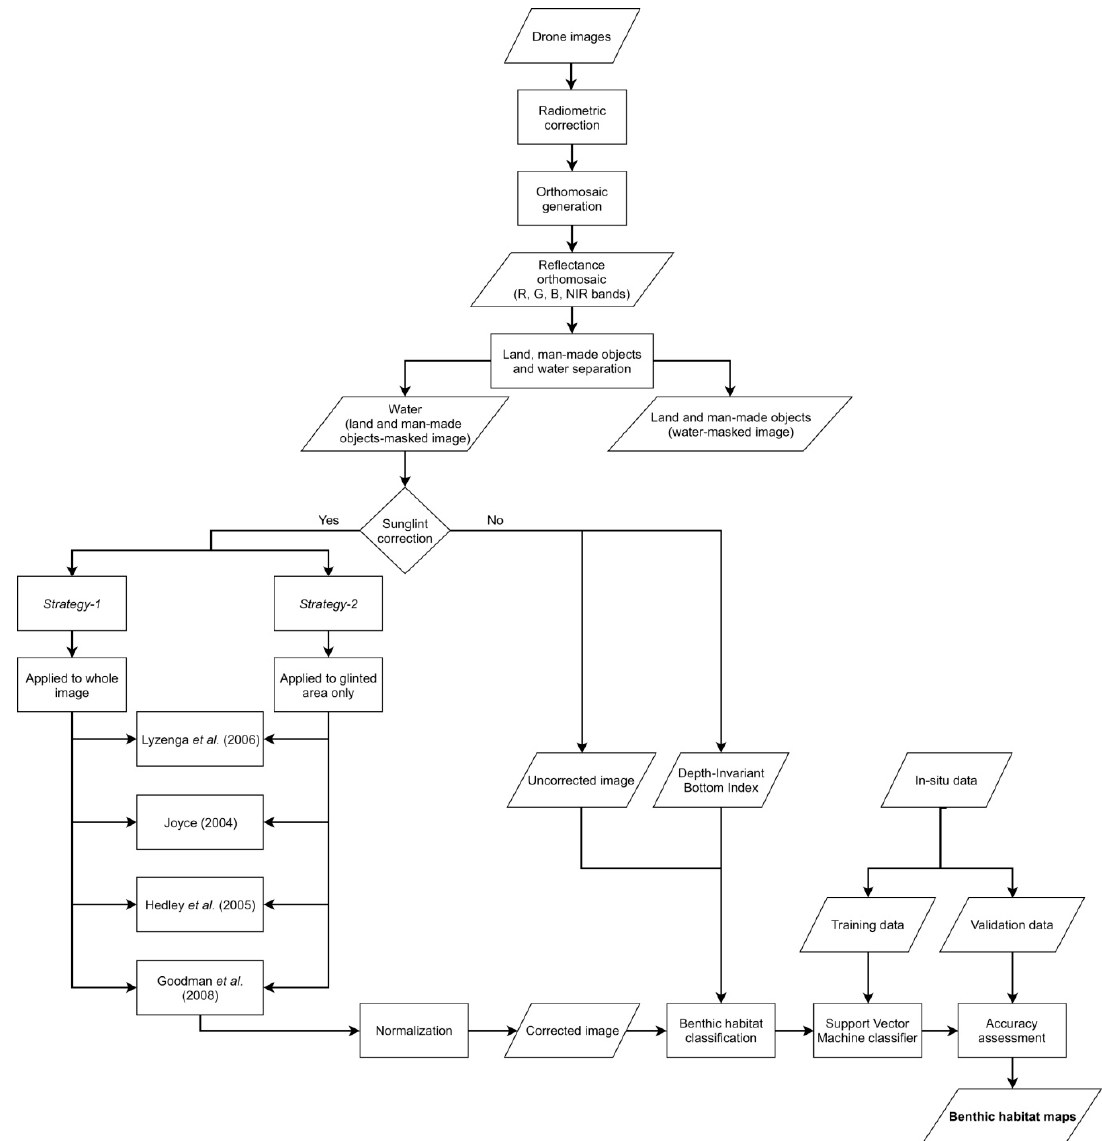
Figure 2. Workflow chart for sun glint removal from unmanned aerial vehicle (UAV) data, subsequent coral habitat classification, and product validation.